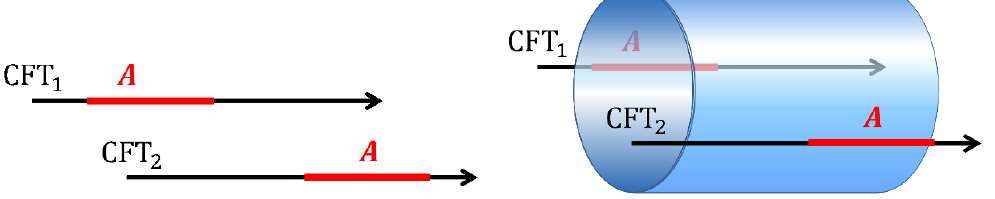
Figure 7 . The left (cid:12)gure shows two intervals in the doubled CFT. The entanglement entropy in this setup can be given by a four-point function with twist operators on a thermal cylinder of periodicity (cid:12) , as sketched in the right